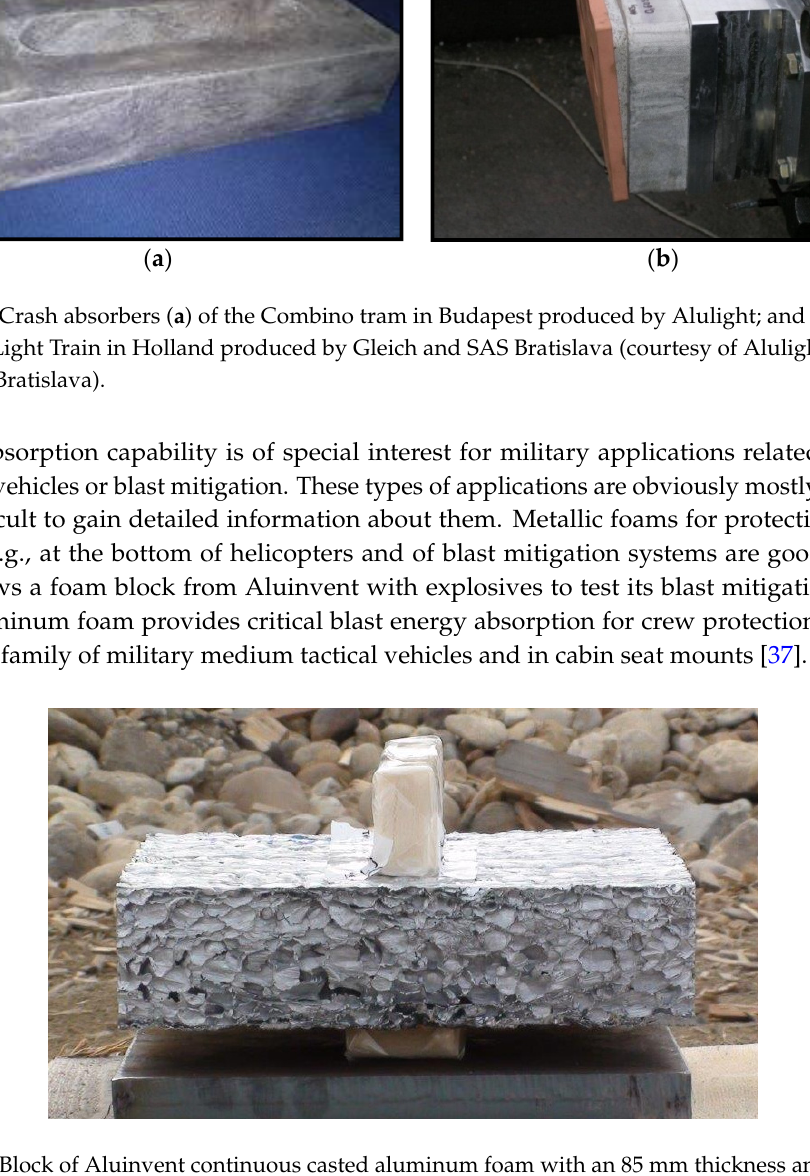
Figure 9. Block of Aluinvent continuous casted aluminum foam with an 85 mm thickness and 15 mm sized bubbles for a blast mitigation test with explosives shortly before detonation (courtesy of Norbert Babcsán, Aluinvent).